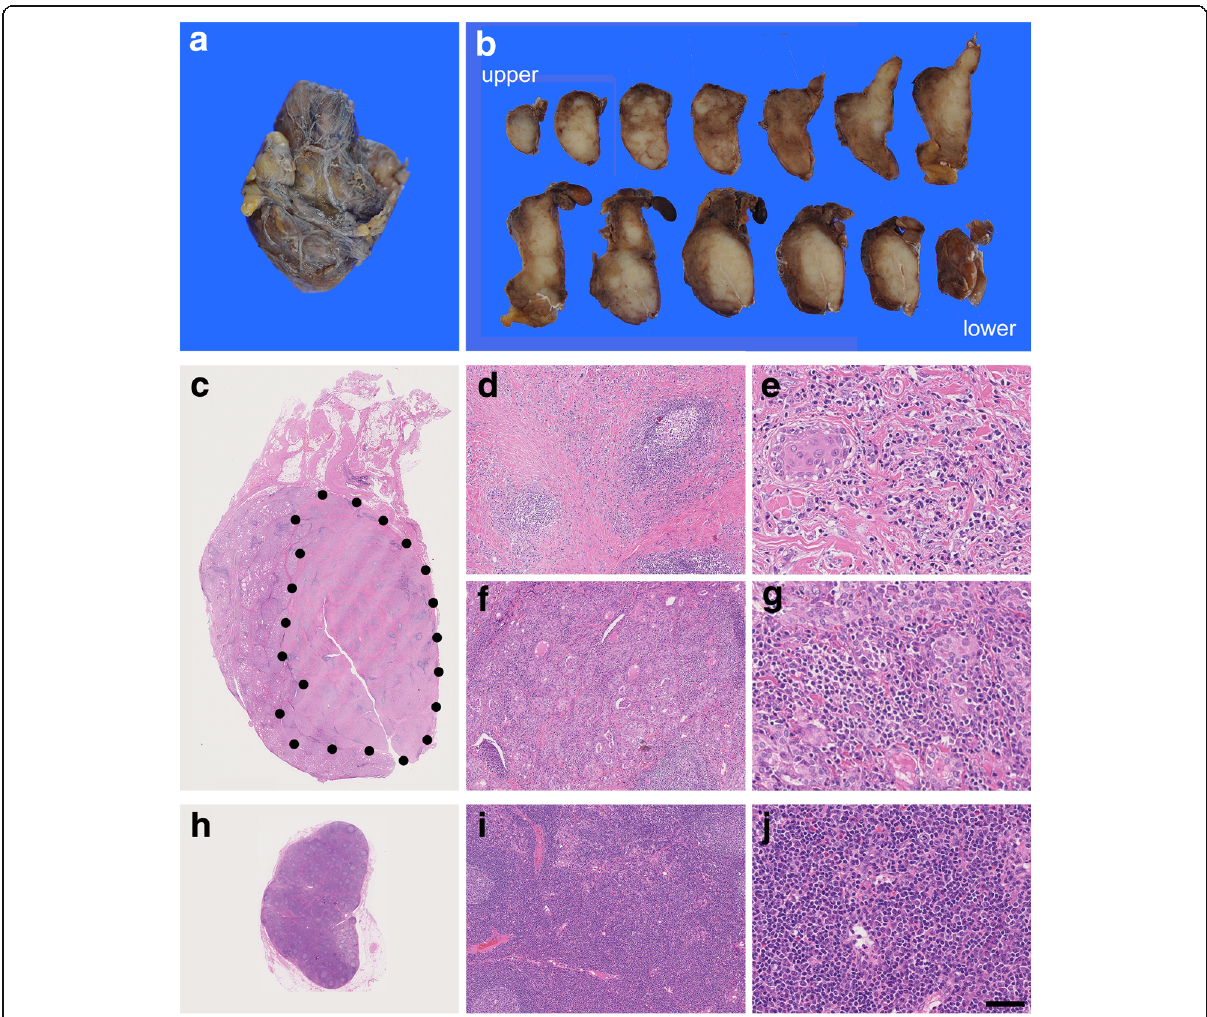
Fig. 1 Gross and histological findings. a , b A circumscribed whitish mass measuring approximately 2.5 cm located in the lower pole of the right thyroidal lobe was misdiagnosed as thyroidal carcinoma after clinical and radiological examination. Another sclerotic lesion in the upper pole had not been detected clinically. c An intrathyroidal sclerotic mass was formed (dotted area). d , e Histologically, the mass lesion was composed of dense stromal fibrosis and lymphoplasmacytic infiltration with occasional lymphoid follicles. Thyroid follicles were almost effaced, and